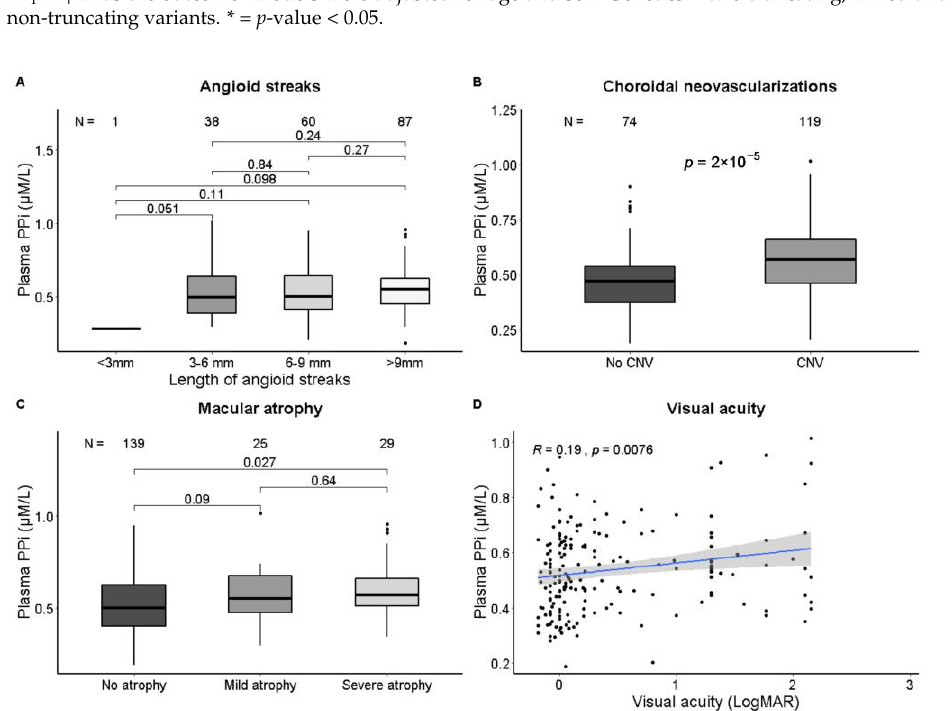
Figure 2. Correlation of plasma PP i and ophthalmological phenotypes. Plasma PP i is correlated with the presence of choroidal neovascularizations ( B ). Patients with severe macular atrophy have higher PP i than patients without macular atrophy ( C ), and worse visual acuity is weakly correlated with higher PP i ( D ). No significant correlation with the length of angioid streaks ( A ) was found. Data were analyzed with Student’s t -test (categorical variables) or the Pearson correlation (continuous variables). A p -value < 0.05 was regarded as statistically significant.